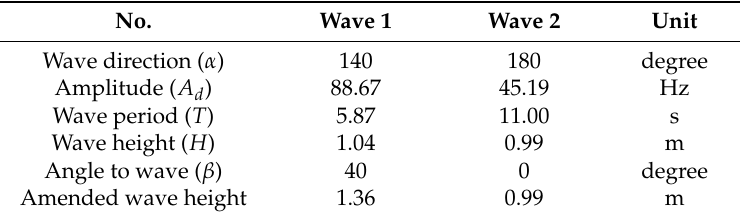
Table 6. Simulation results for two waves.